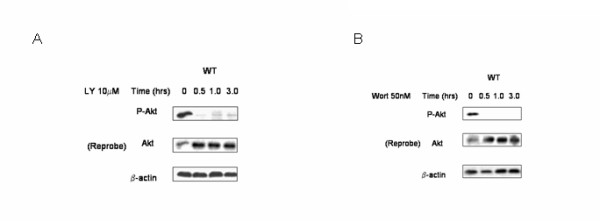
Akt phosphorylation is reduced by PI3K inhibition. Wild type ACHN cells were incubated with (a) LY-294,002 (10 μM) or (b) wortmannin (50 nM) for the times indicated and immunoblotted with antibodies against Akt, phospho-Akt, or β-actin. A representative experiments is shown of three done.